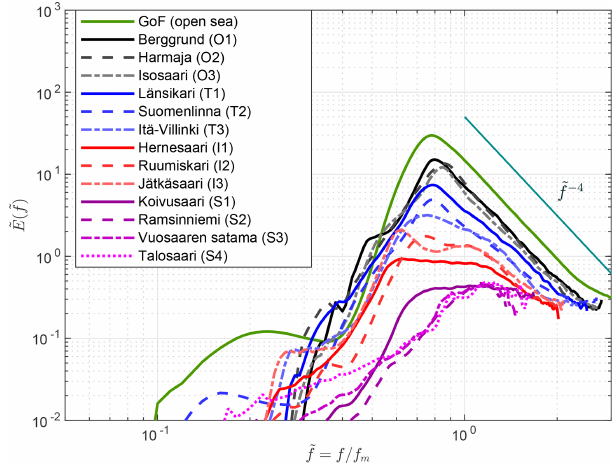
Figure 3. The mean wave spectra divided into the open sea and four archipelago areas: outer archipelago (O1–O3), transition zone (T1– T3), inner archipelago (I1–I3), and sheltered archipelago (S1–S4). An overview of the locations can be found in Fig.